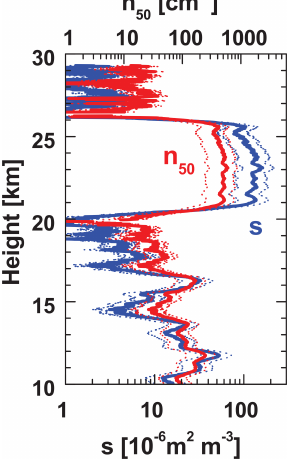
Figure 12. Retrieval results for 29 January 2020 in terms of surface area s and particle number concentration n 50 (proxy for CCN) with error margins representing the uncertainties as given in Table 4 for the Raman lidar option in the case of aged